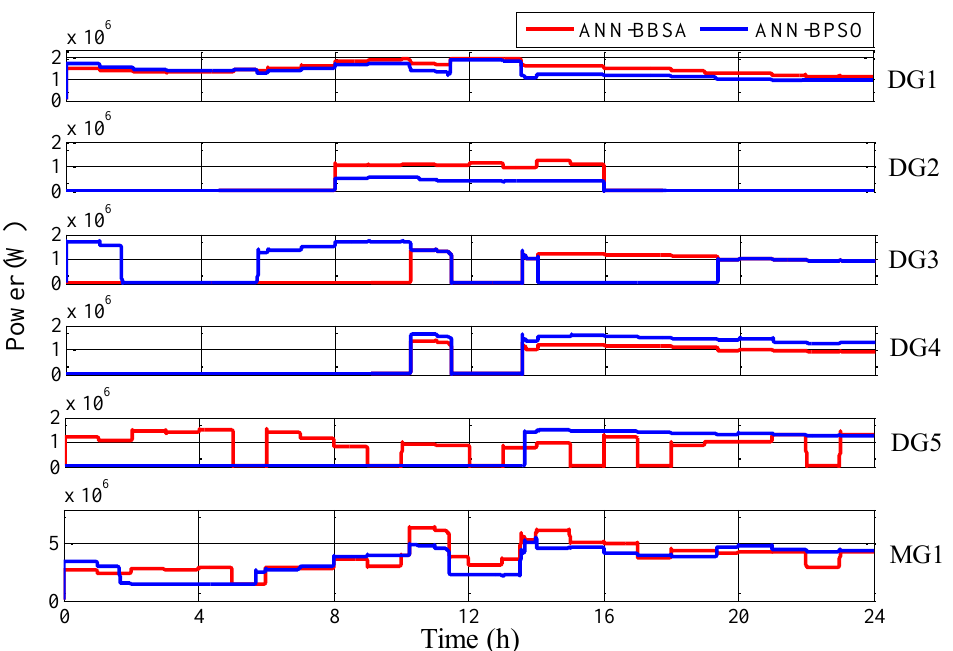
Figure 13. Test 2 testing data results using ANN-BBSA and ANN-BPSO in the microgrid at bus 5.